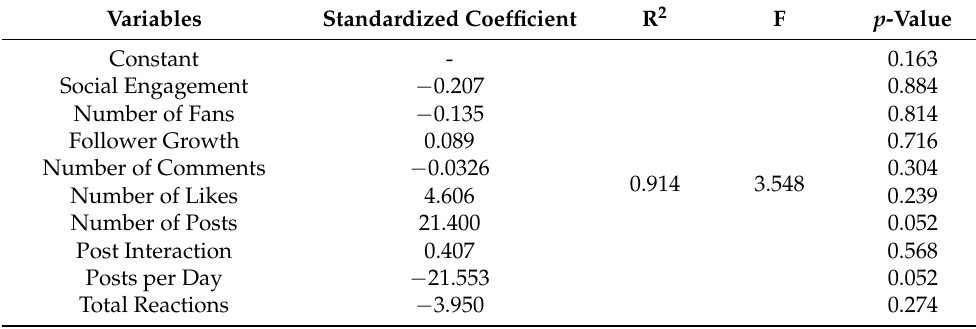
Table 4. Impact of social media analytics on CPNs websites’ organic traffic.